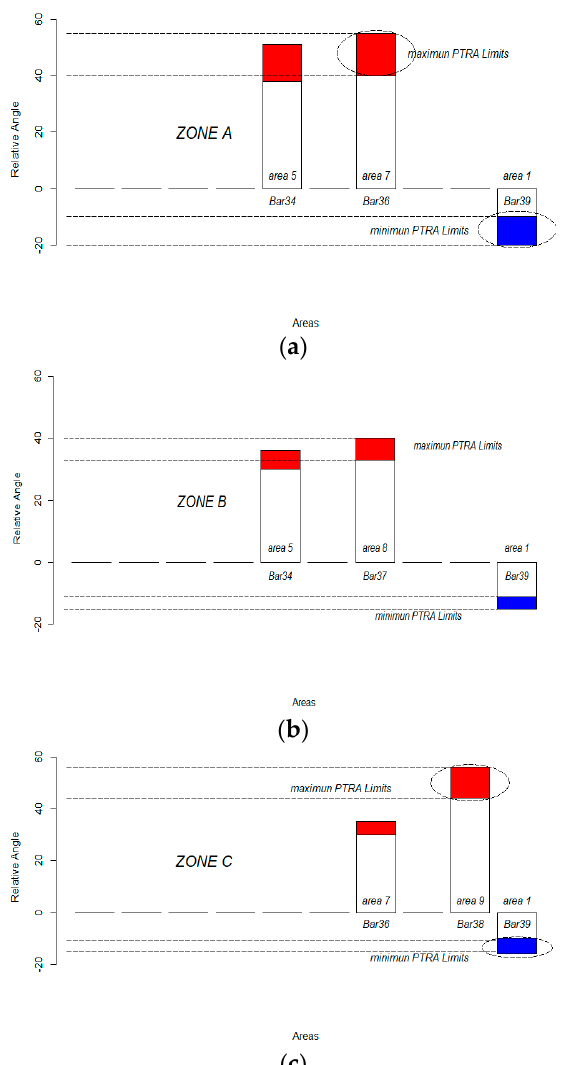
Figure 3. Evaluation of fault events in the three zones: ( a ) Zone A, ( b ) Zone B, and ( c ) Zone C.